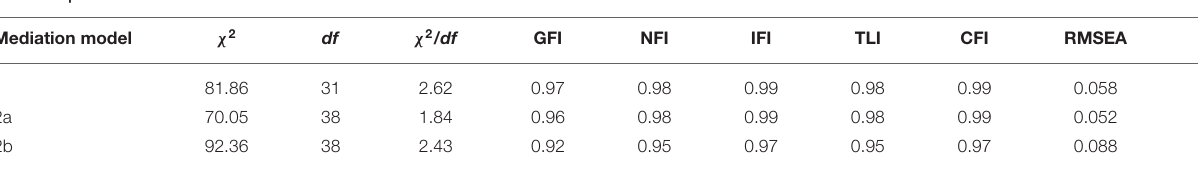
TABLE 3 | Fit statistics for mediation